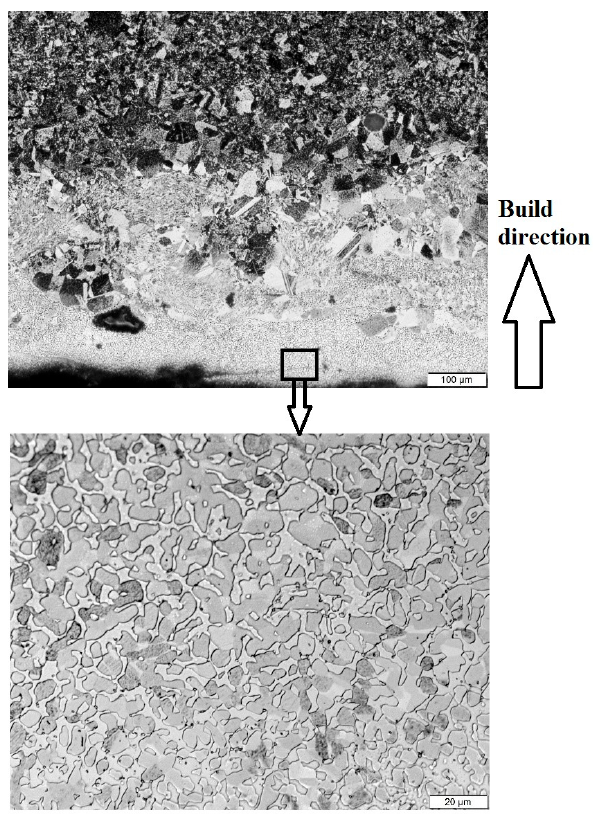
Figure 5. Microstructures from the bottom portion of the electron beam melting (EBM) part built on a steel support plate.